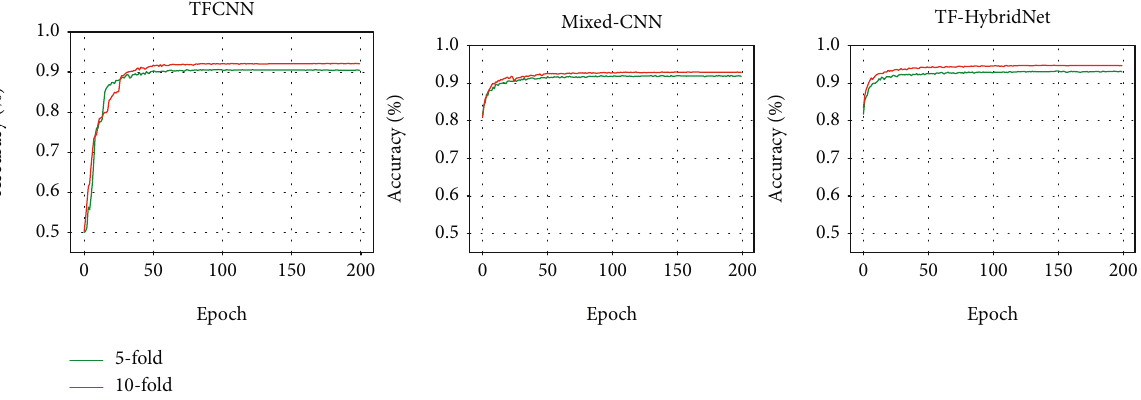
Figure 4: The accuracy of the validation set on TFCNN, Mixed-CNN, and TF-HybridNet.